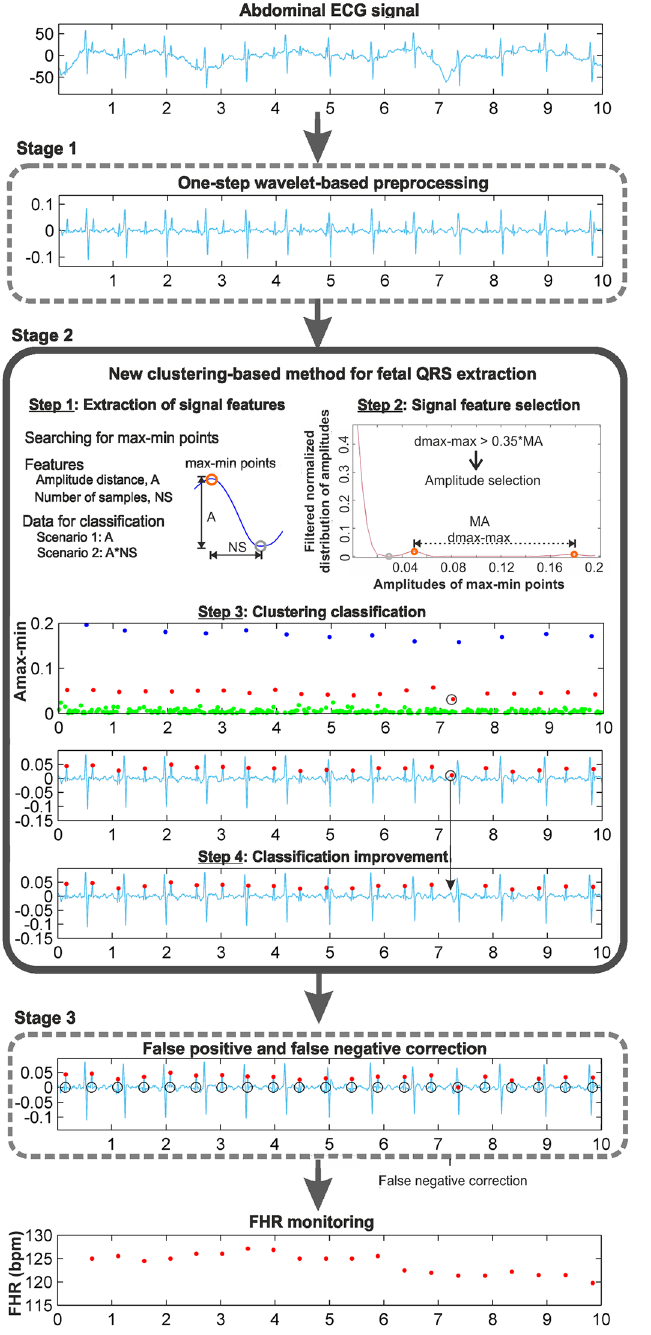
Fig 1. Clustering-based procedure for FHR